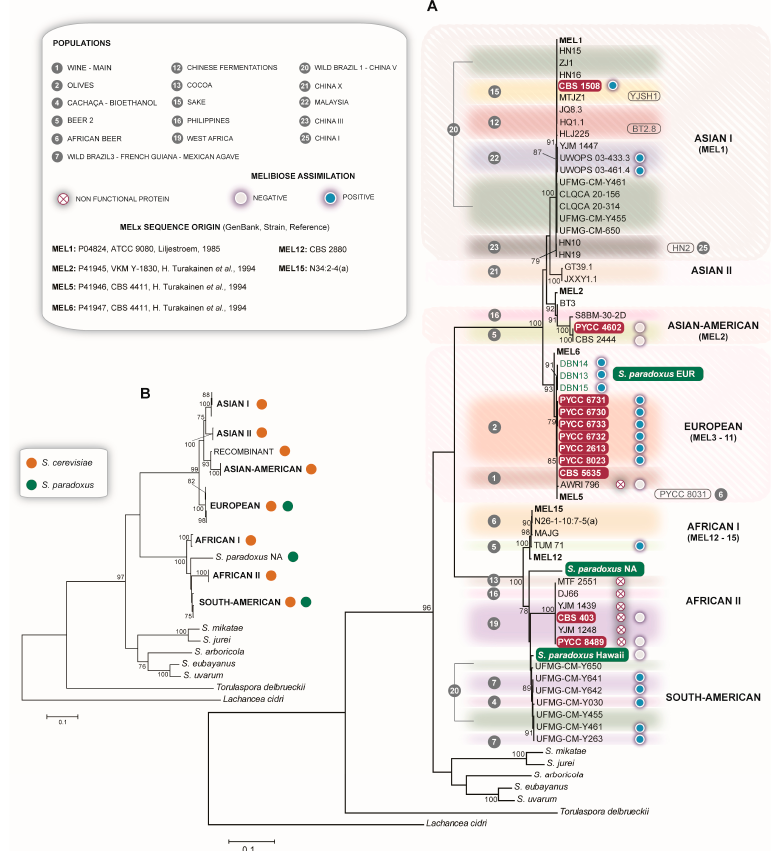
Figure 4. Phylogenetic analysis of MEL alleles of S. cerevisiae. ( A ) Phylogenetic overview of MEL alleles from 16 populations of S. cerevisiae . For comparison, MEL sequences from other Saccharomyces species were included together with S. cerevisiae MEL alleles ( MEL1 , MEL2 , MEL5 , MEL6 , MEL12 and MEL15 ) retrieved from the literature and from the NCBI database ( MEL12 and MEL15 were retrieved directly from genomic assemblies). For S. paradoxus , sequences from representatives of the European (EUR), North American (NA) and Hawaiian populations were added. Incomplete sequences that could be assigned to an allelic group, but that were not used in the final phylogeny are indicated next to the tree in a rounded rectangle. The former type strains of S. cerevisiae are indicated in red rectangles; ( B ) simplified phylogeny of MEL alleles in the genus Saccharomyces . The two phylogenetic trees were constructed using the Maximum Likelihood method and the Tamura 3-parameter model. Bootstrap values > 75% are indicated (1000